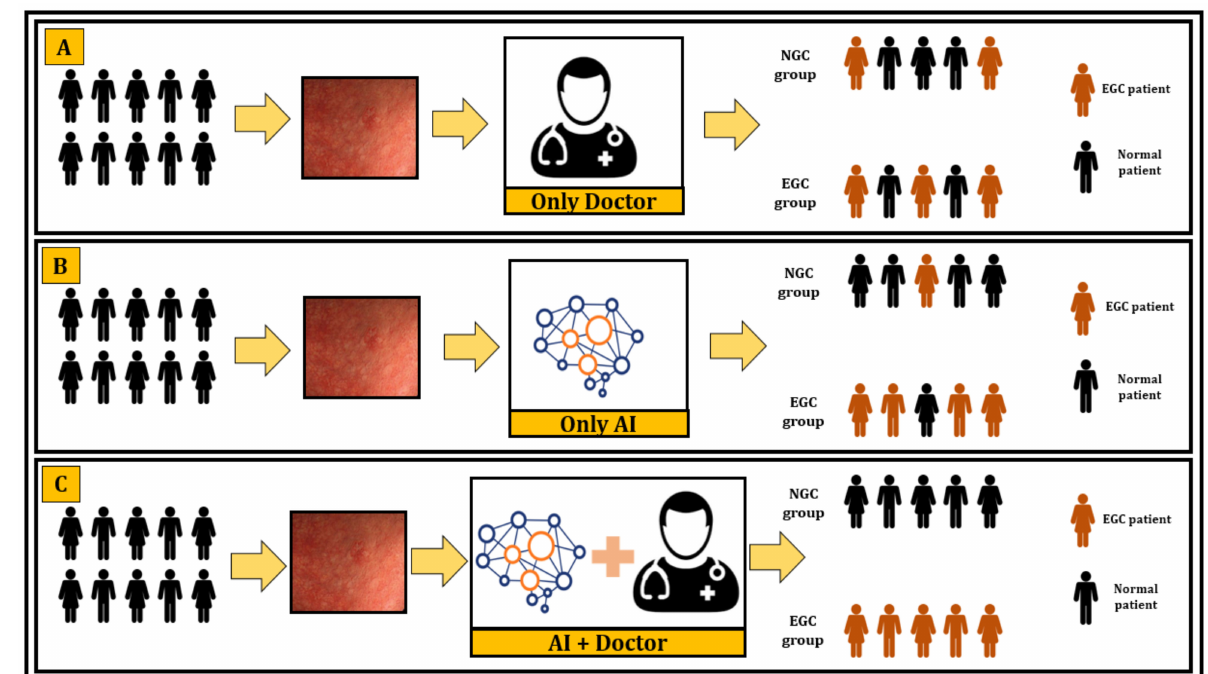
Figure 5. Propose diagnosis of EGC by man with machine. ( A ) Screening of EGC by physicians only can increase false- positive and false-negative cases; ( B ) screening of EGC by AI only can also increase false-positive and false-negative; ( C ) combined decision based on AI plus physicians can accurately diagnose